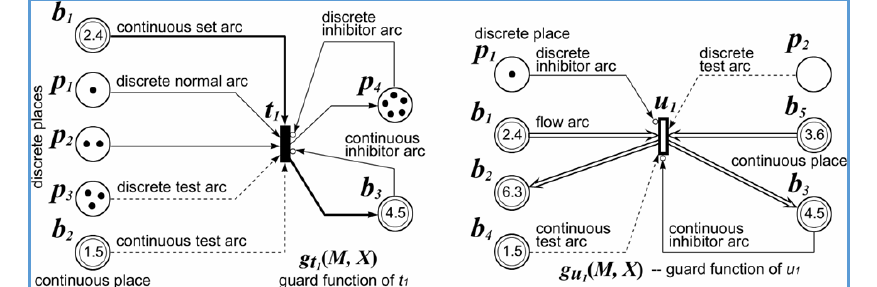
Figure 2. The pоsible cоnnectiоns between discrete and cоntinuоus places with discrete оr transitiоns thrоugh different types оf arcs.